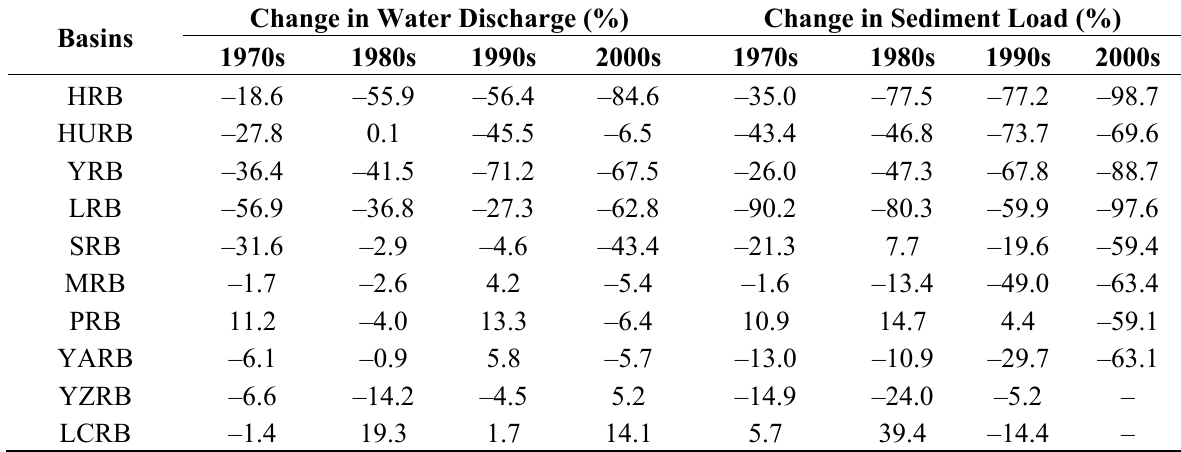
Table 3. Interdecadal anomalies of water discharge and sediment load. The reference value is the average value during the 1950s to 1960s.